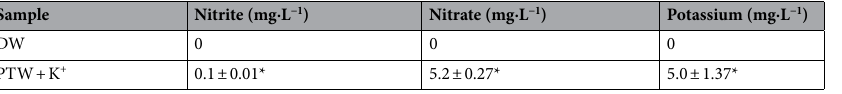
Table 1. Ion concentration of the plasma-treated water (PTW) containing potassium ions (K + ) compared with the untreated deionized water (DW). *An asterisk indicates a significant difference between the untreated deionized water and plasma-treated water ( P <